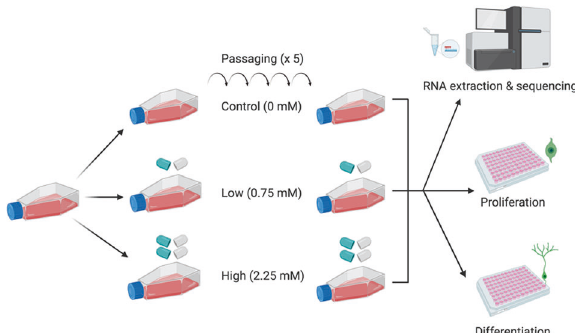
Fig. 1 A summary of our experimental protocol. Cells were treated with control (0 mM), low (0.75 mM) or high (2.25 mM) doses of lithium across fi ve passages (~15 days) and submitted to nucleic acid extraction and RNA-sequencing, a proliferation protocol, and adifferentiation